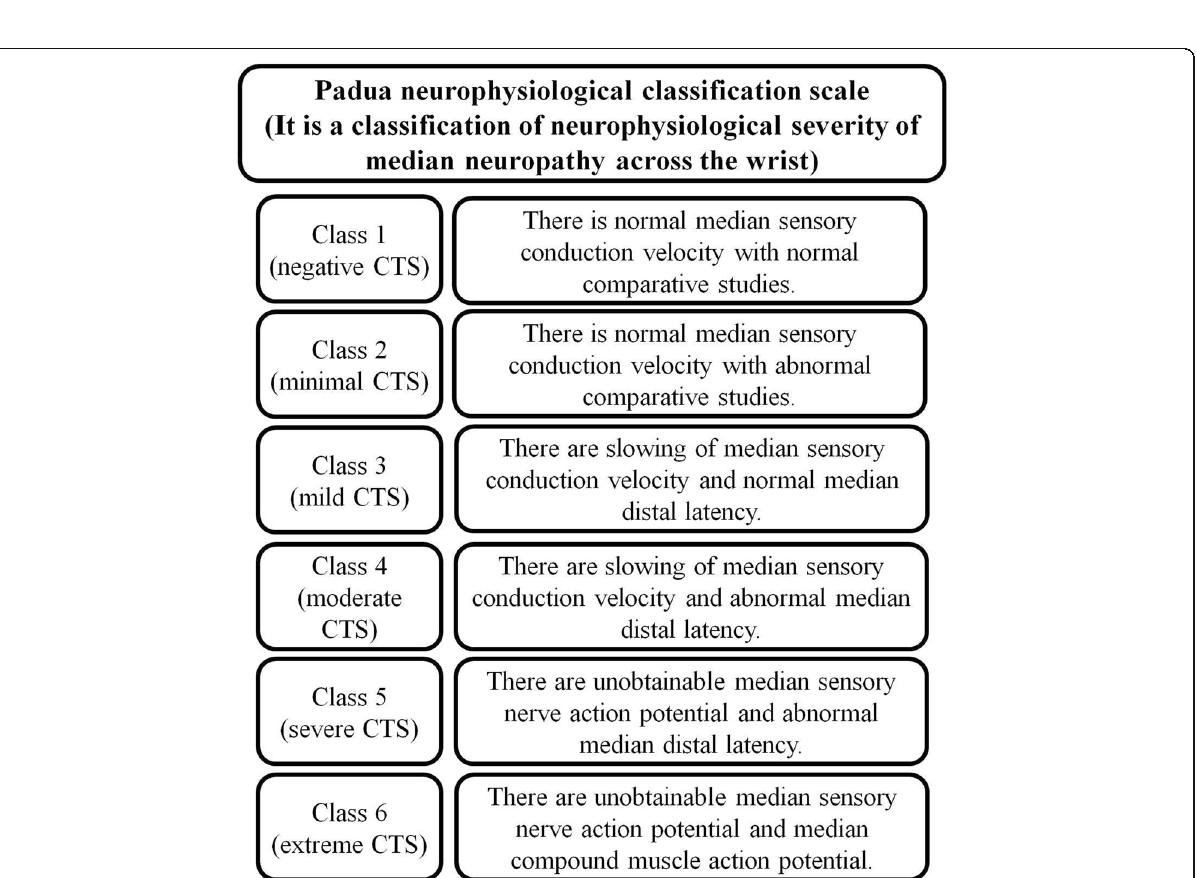
Fig. 5 Illustration of the Padua neurophysiological classification scale [22]. CTS carpal tunnel